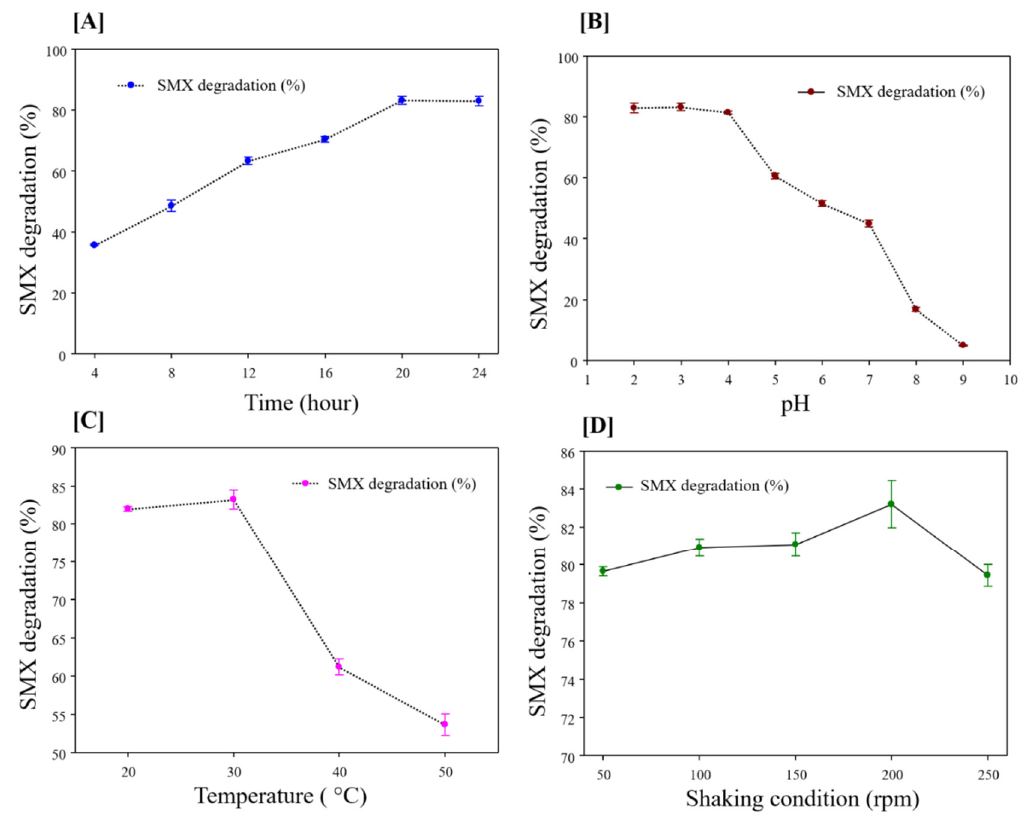
Figure 9. Effect of time ( A ), pH ( B ), temperatures ( C ), and shaking conditions ( D ) on SMX degradation by the α -Cellulose- Fe 3 O 4 -CTNs-SH-Laccase.